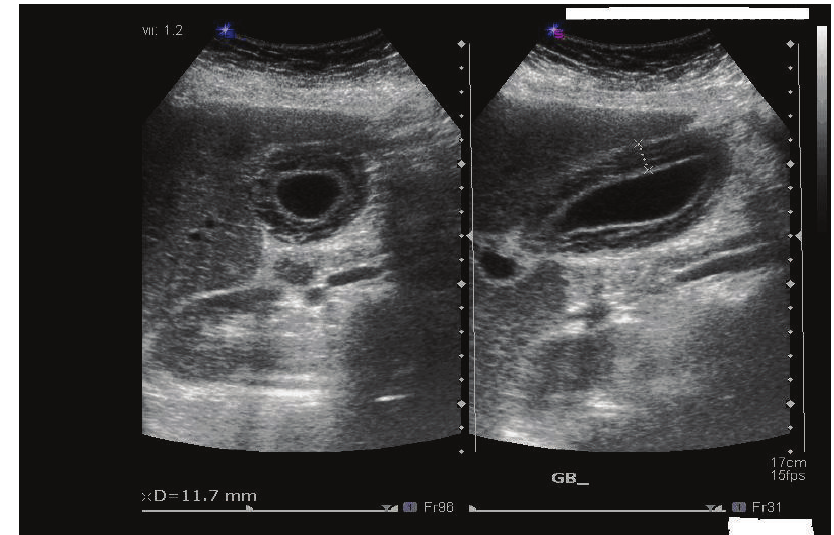
Figure 1: U/S of abdomen showing the thickened gallbladder